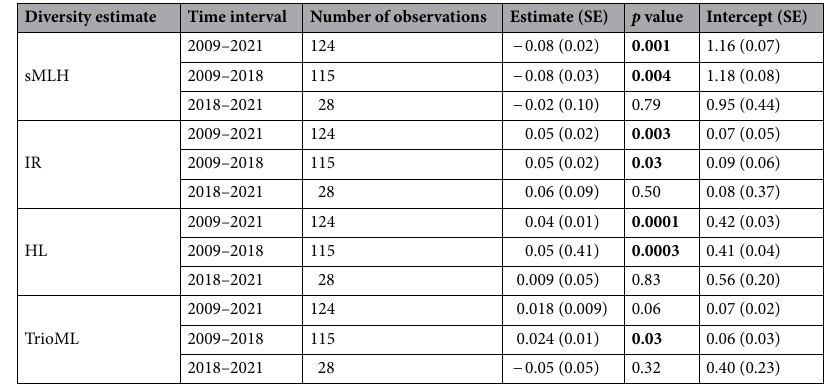
Table 2. Results of the generalized linear models (GLMs) of the effect of time on estimates of individual genetic diversity and the inbreeding index. Significant p values are highlighted in bold.